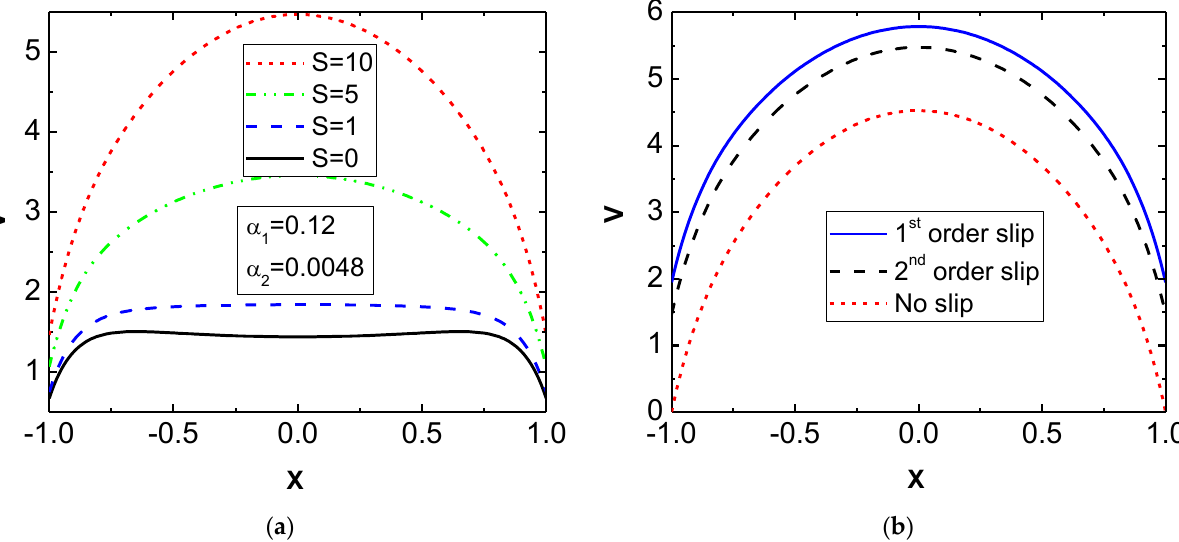
Figure 8. Influences of S on velocity distributions in microchannels for 10 K = , 1 Ha = , and Figure 8. Influences of on velocity distributions in microchannels for K = 10, Ha = 1, and Ω = 1. 1  = . ( a ) Second-order slip; ( b ) Comparison of no-slip, first-order, and second-order slips at S = 10. ( a ) Second-order slip; ( b ) Comparison of no-slip, first-order, and second-order slips at S = 10.